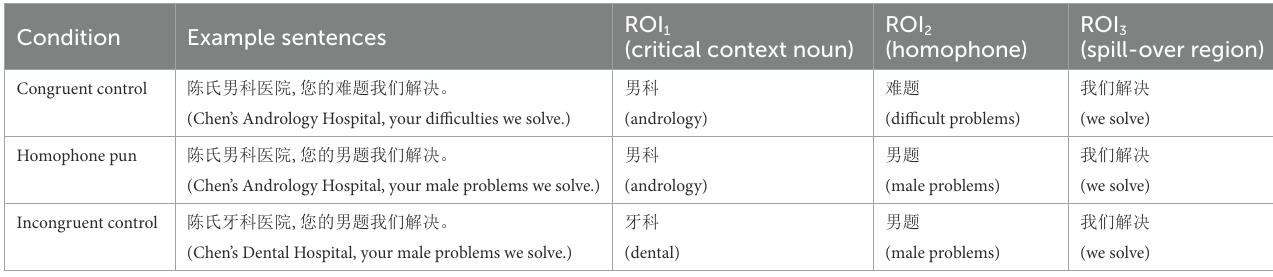
English translations were given in parentheses.